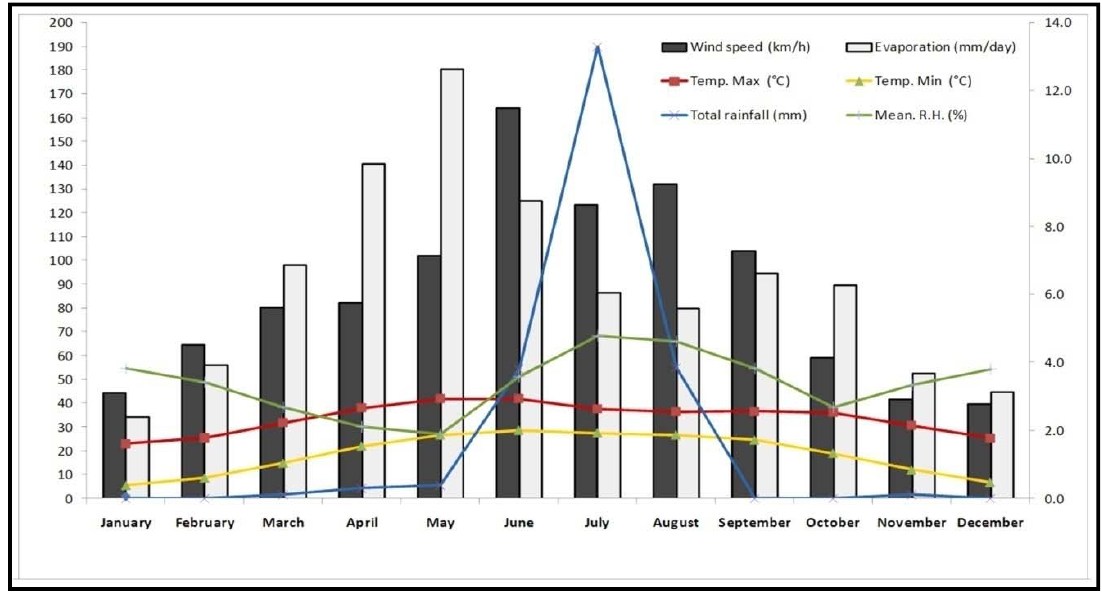
Figure 1. Month wise average weather data of Bikaner district during the study period (January to December, 2018).